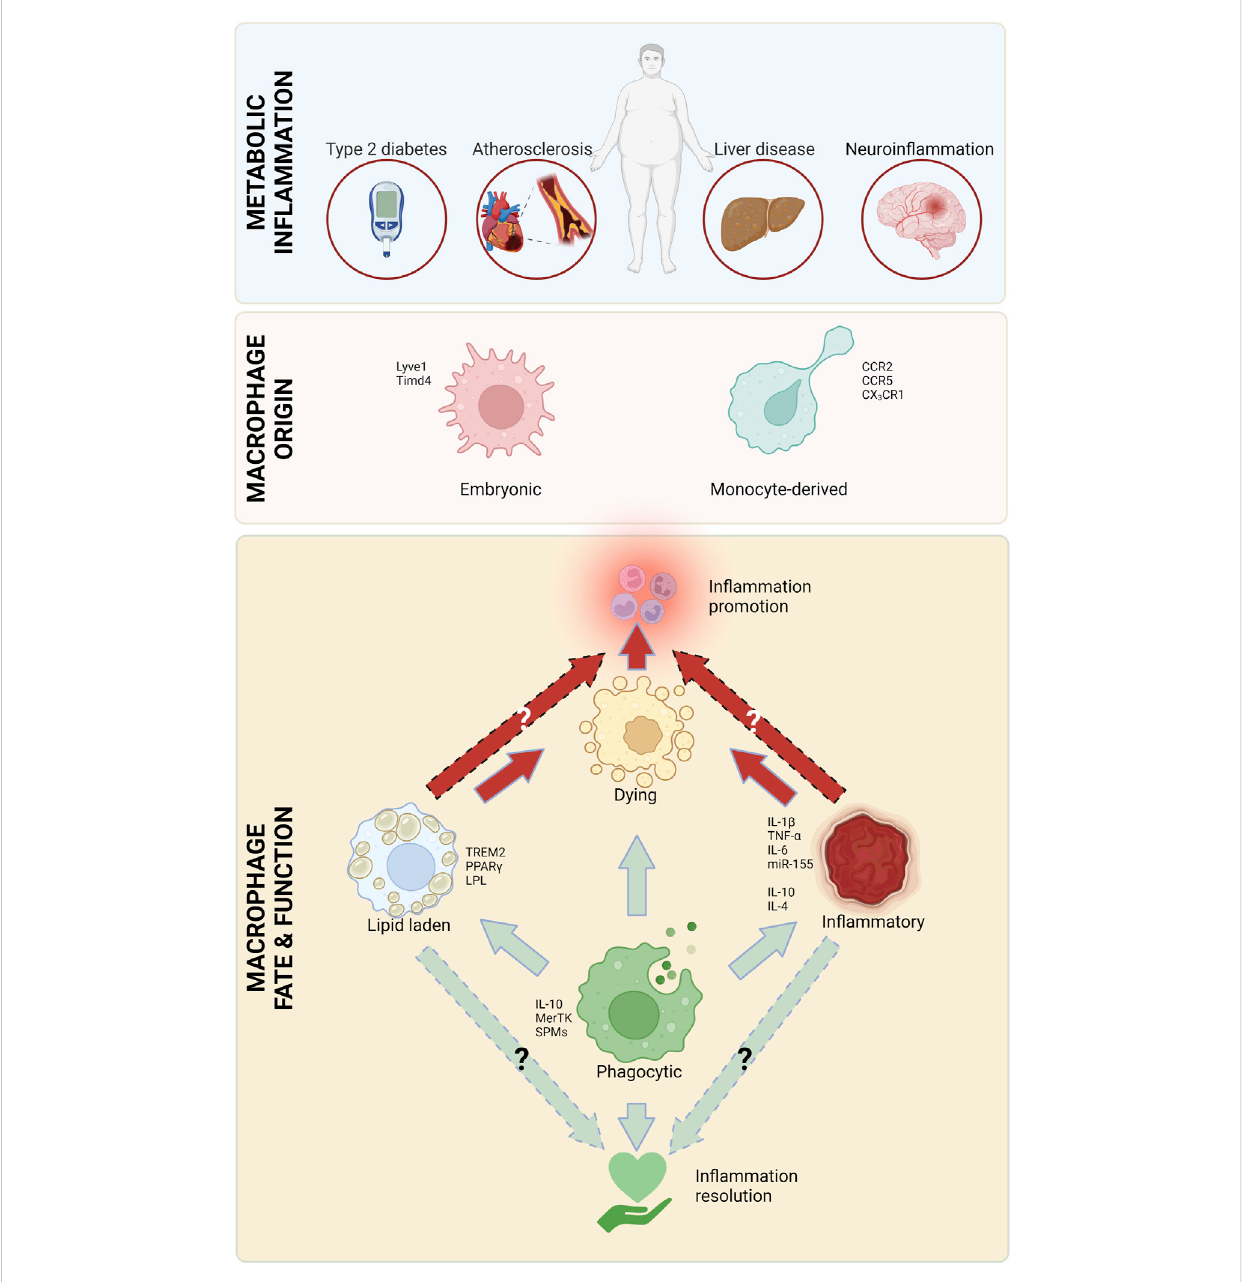
FIGURE 1 Majormacrophageattributesinmetabolicin fl ammation.Macrophages,originating fromcirculatingmonocytesandembryonictissuesplayacritical role in all types of metabolic in fl ammation. There are several types of macrophages that are involved in in fl ammation initiation and heightening (red arrows), as well as resolution (green arrows). Created with